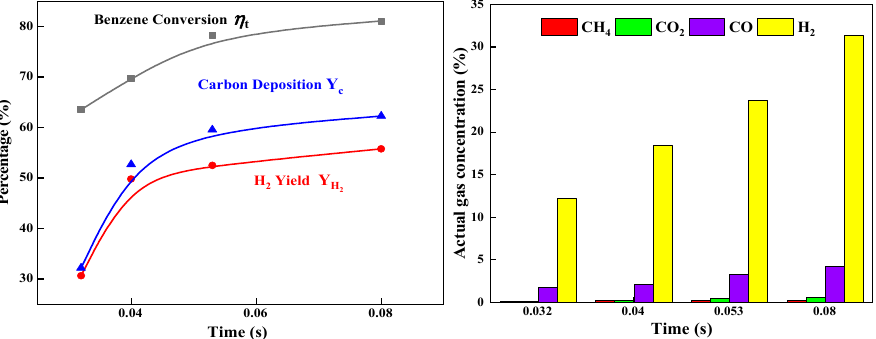
Table 4. Distribution of carbon-containing species in the products. Figure 3. Effect of residence time on benzene cracking. Figure 3. Effect of residence time on benzene